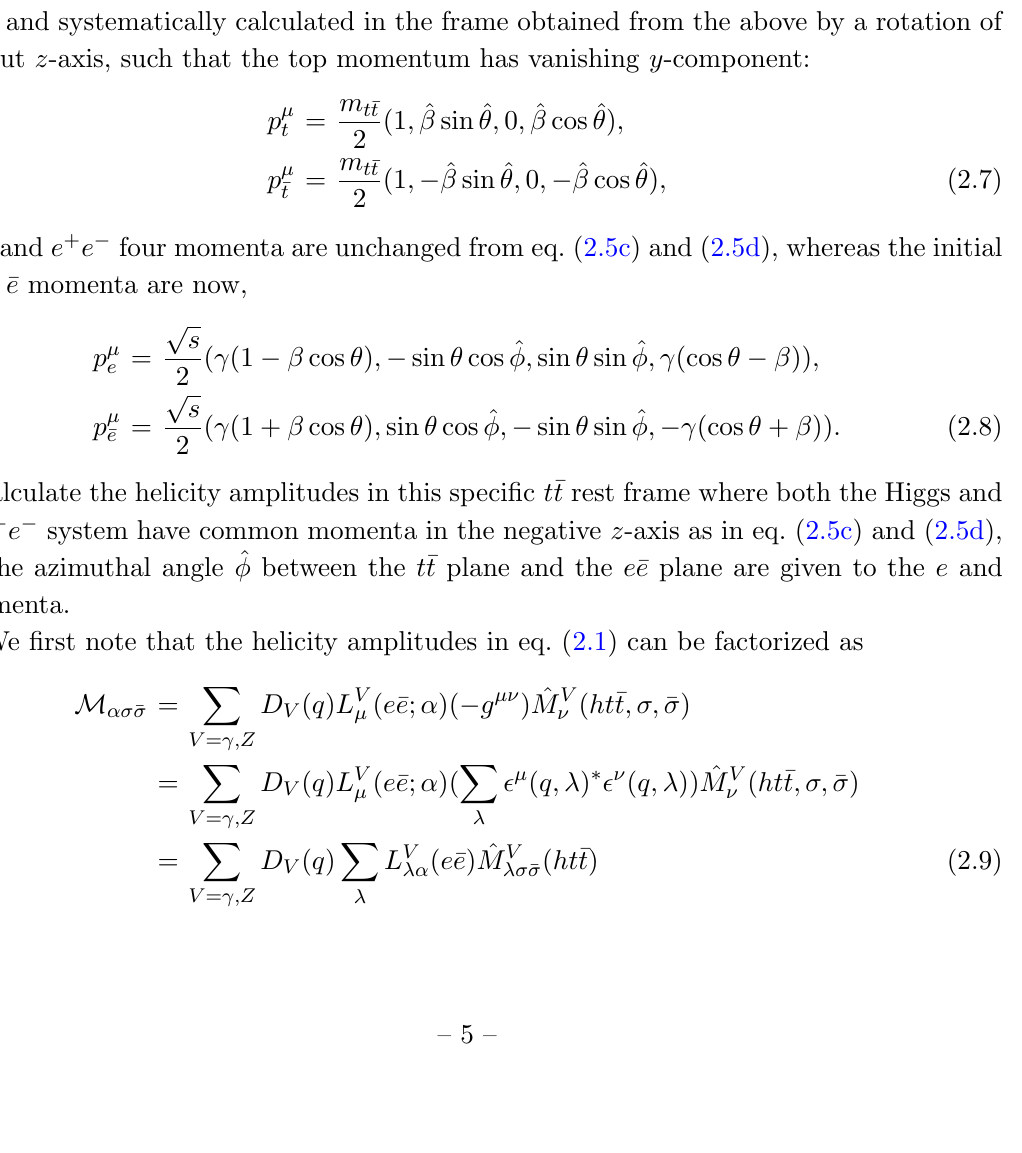
ht (cid:22) t process in the e (cid:22) e rest frame and in the t (cid:22) t rest frame.